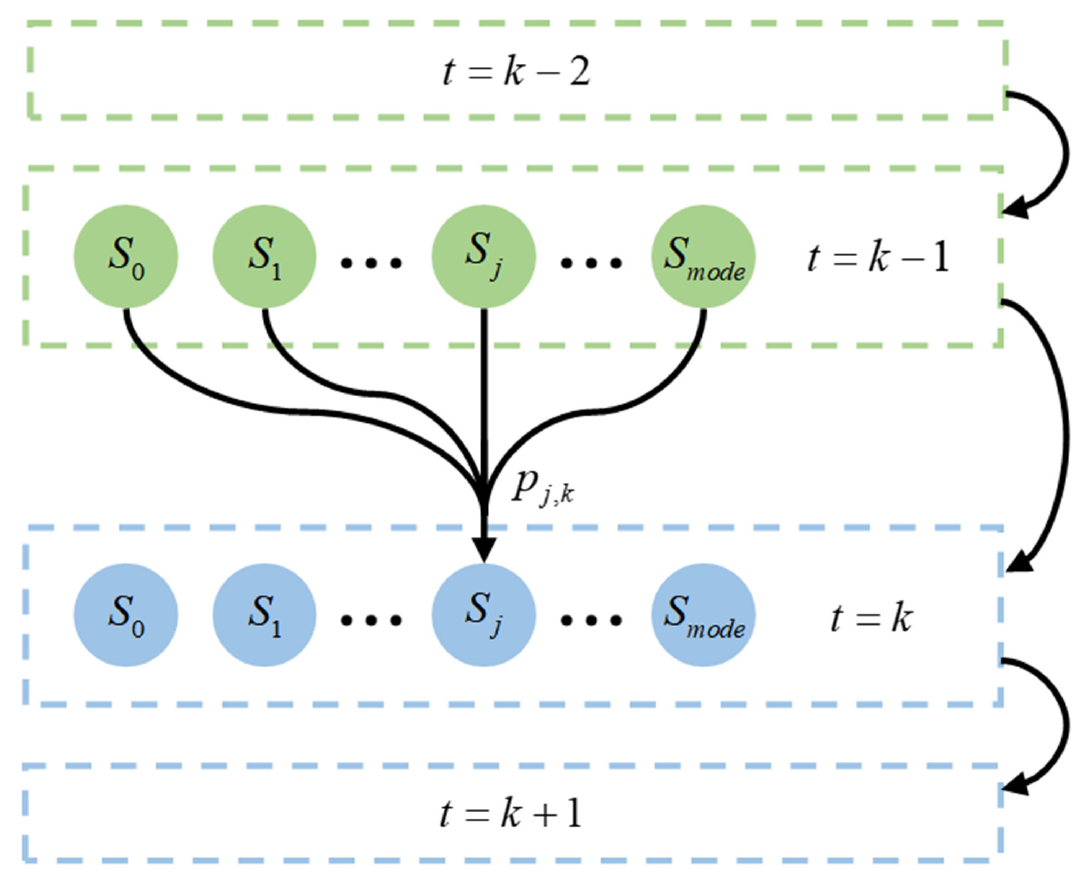
Figure 2. Markov Chain.